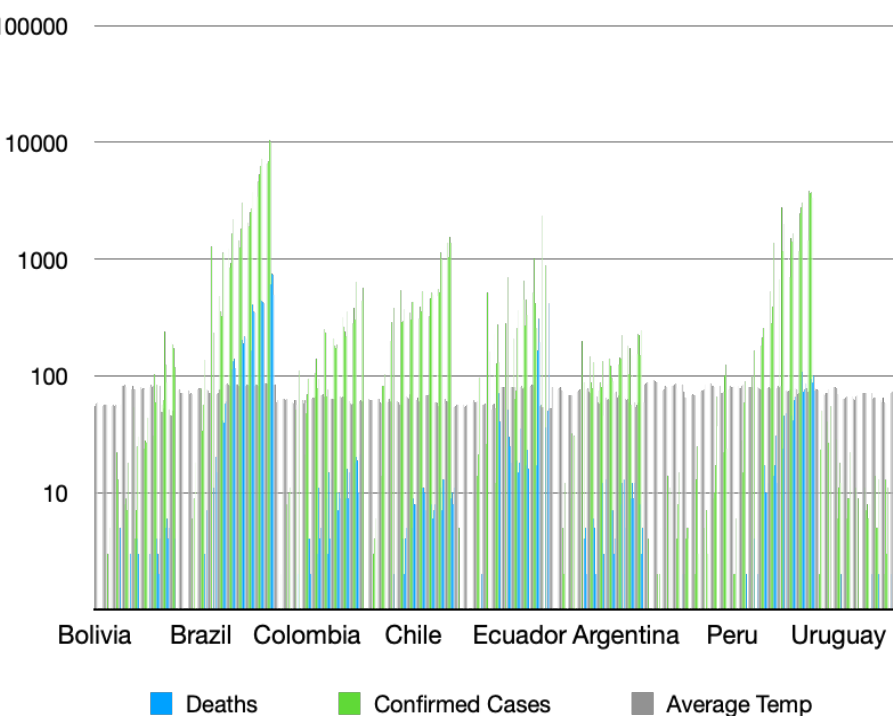
Fig. 6. Drivers of COVID-19 mortality in the South American